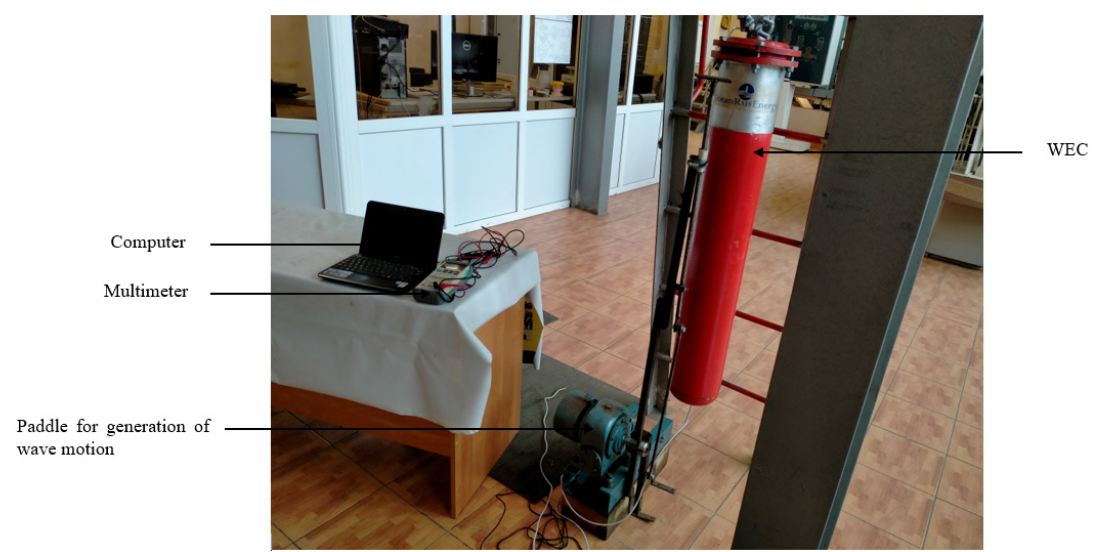
Figure 6. Experimental setup for the point-absorber WEC generator.